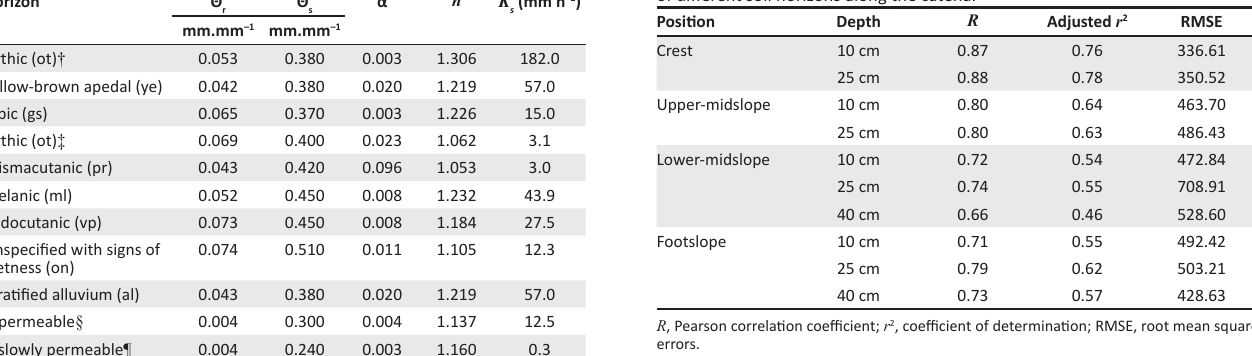
TABLE 4: Van Genuchten parameters of dominant soil horizons. Horizon